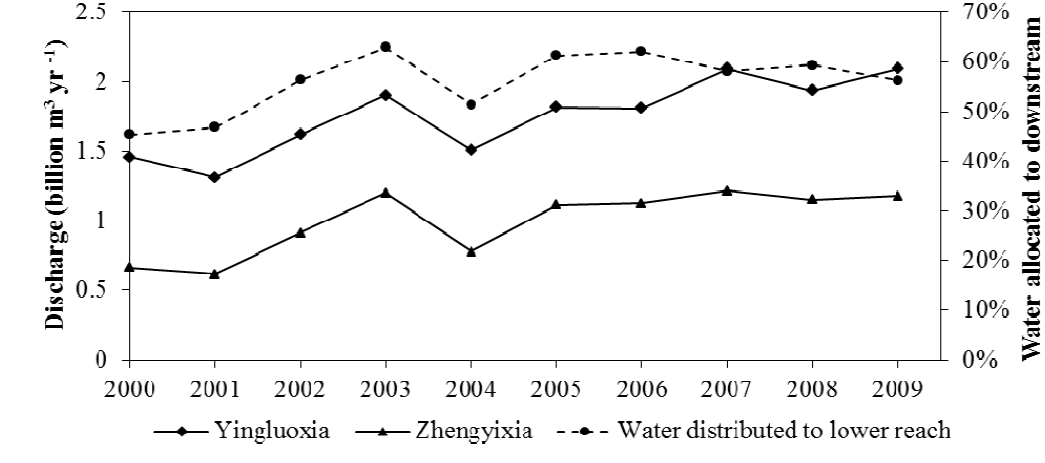
Figure 6. Discharge of the Heihe River at the Yingluoxia and Zhengyixia gauge stations and Percentage of the total flow distributed to the lower reach of the Heihe River